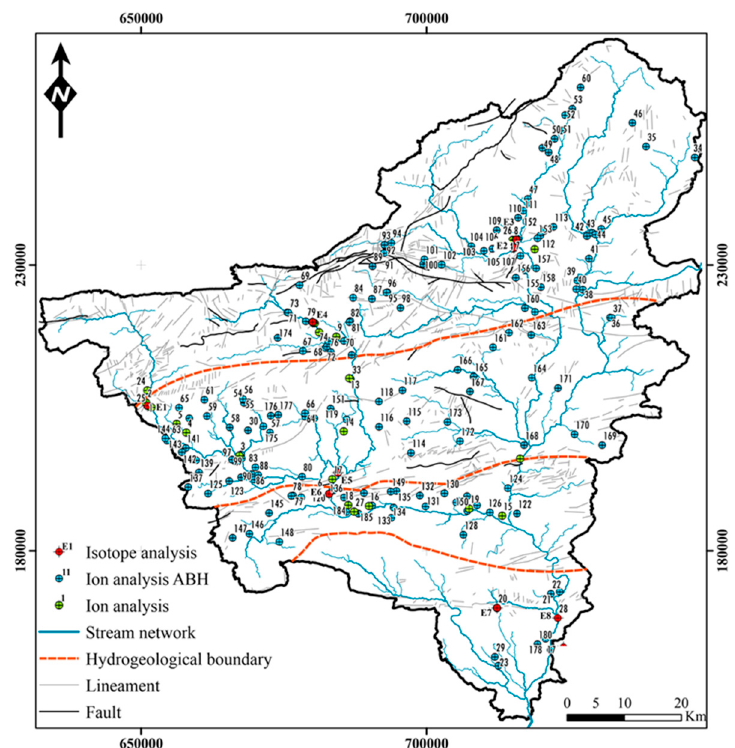
Figure 9. Location map of all water points (184) where hydrochemical data are available (current study and water agency archives).